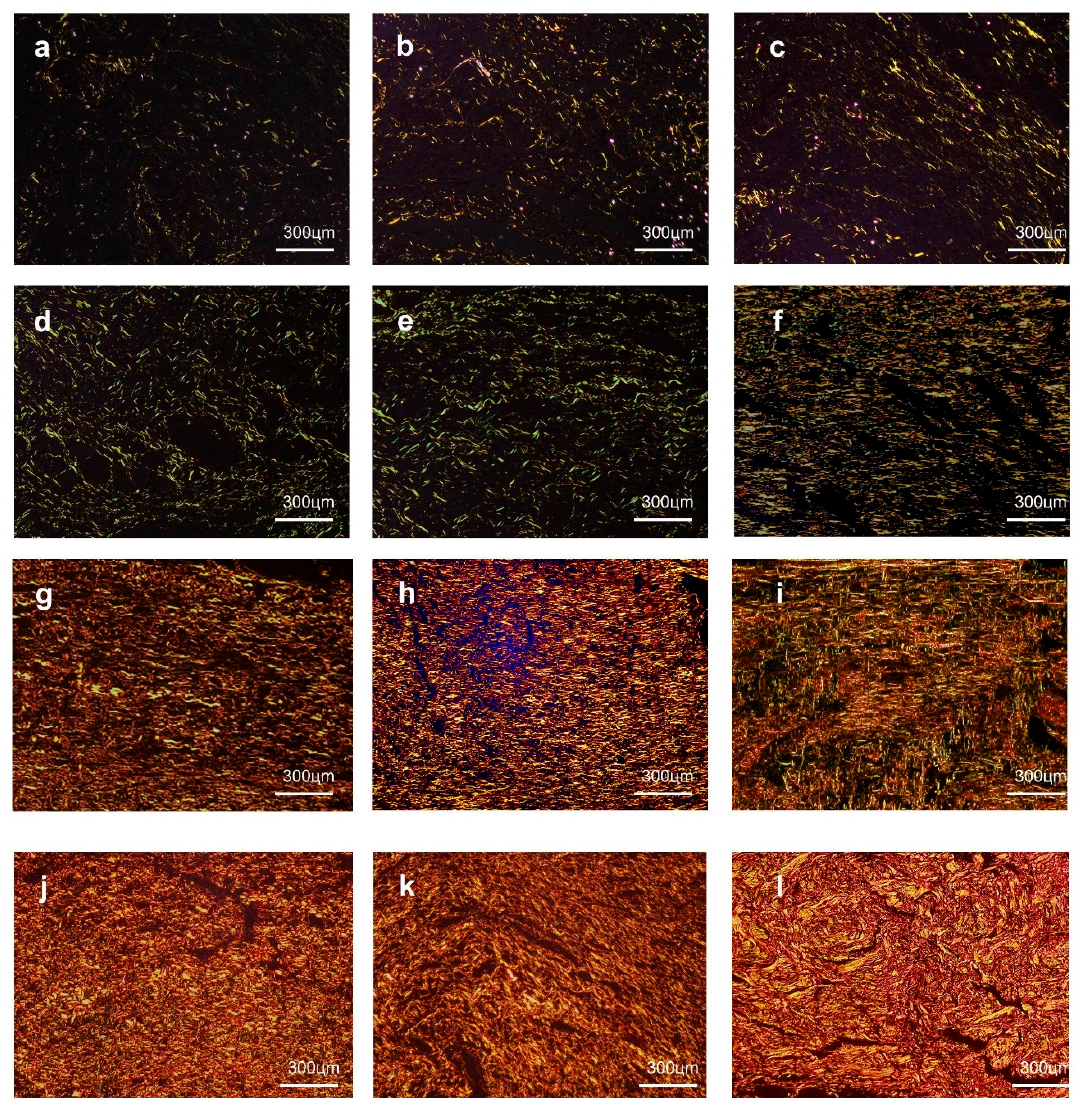
Figure 7. At day 3, a small amount of greenish type III collagen deposits were observed in the CTR ( a ), GEL ( b ), and GELPG ( c ). At day 7, reticular type III collagen was seen in the CTR ( d ) and GEL ( e ), while parallel arrangements of type I collagen were seen in GELPG ( f ). At day 14, dense parallel arrangements of type I collagen were observed in the CTR ( g ) and GEL ( h ), whereas, in GELPG ( i ), the fibers were slightly interlaced. At day 21, gross, interlaced type I collagen fibers were seen in all of the groups, but they were less compact in the CTR ( j ) and GEL ( k ) than in GELPG ( l ) (Sirius Red / polarized light, 400 × magnification).